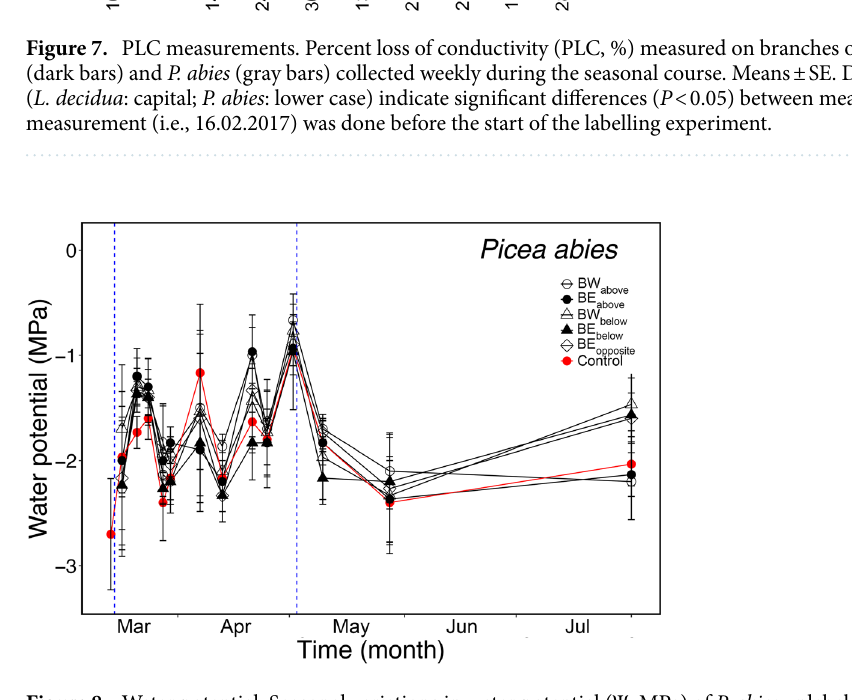
Figure 8. Water potential. Seasonal variations in water potential (Ψ; MPa) of P. abies unlabeled (red symbols; breast height and west exposed) and labelled specimens (black symbols). From labelled trees, samples were collected at different positions (see Fig. 2a): west exposed above (BW above ; open dots) and below (BW below ; open triangles), and east exposed above (BE above ; full dots), below (BE below ; full triangles) and opposite (BE opposite ; open diamond). Mean ± SE. Blue dashed vertical lines indicate the time of bag installation (14.03.2017) and removal